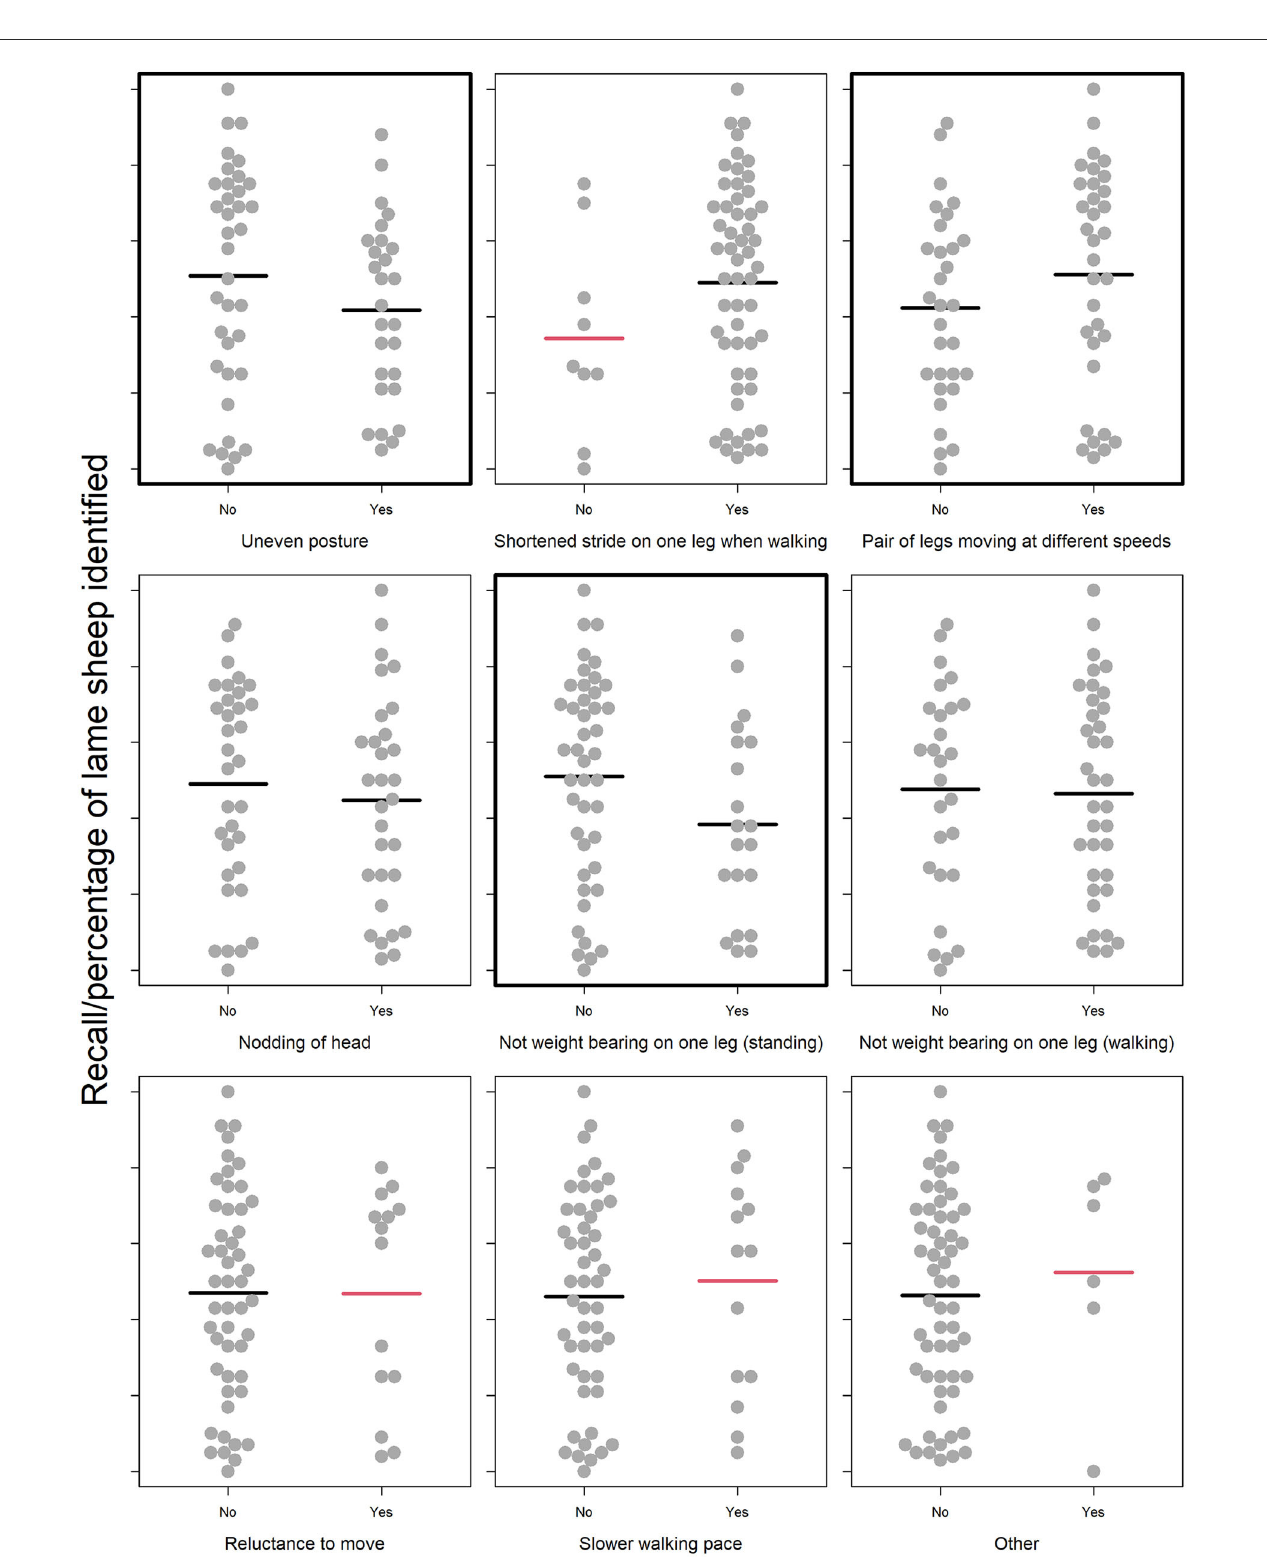
FIGURE4 Relationship between participants’ recall scores and the signs they looked for when playing the simulation game. Recall scores of participants that did not and did look for each of eight classic signs of various stages of lameness (29), plus an extra category of “Other” signs looked for which we asked participants to elaborate upon. For categorical variables, individual participant data points are jittered using the beeswarm algorithm (R Package “beeswarm”) and mean recall scores are plotted as bold horizontal lines underneath the data points. Mean recall scores colored red are those likely to be poor estimates due to small sample sizes i.e., the lower or upper quartile exceeds the 95% confidence limits of the mean. The plot is framed in a bold outline if that relationship was formally tested